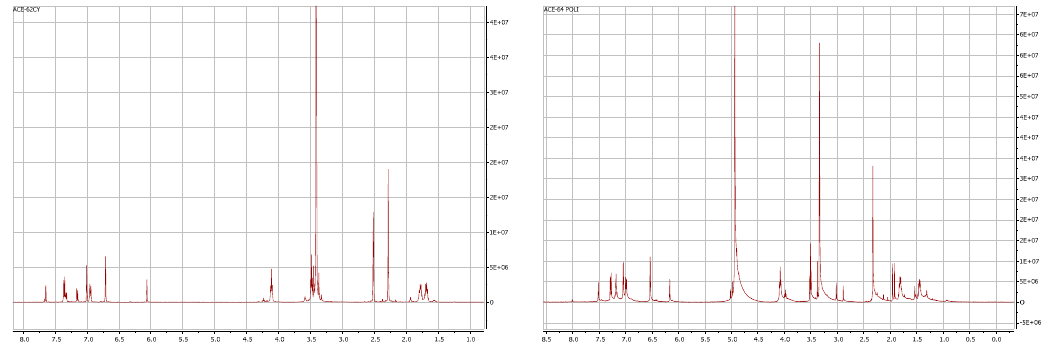
Figure 1. 1 H-NMR spectra of compounds 3 and 6 , respectively, in DMSO- d 6 .